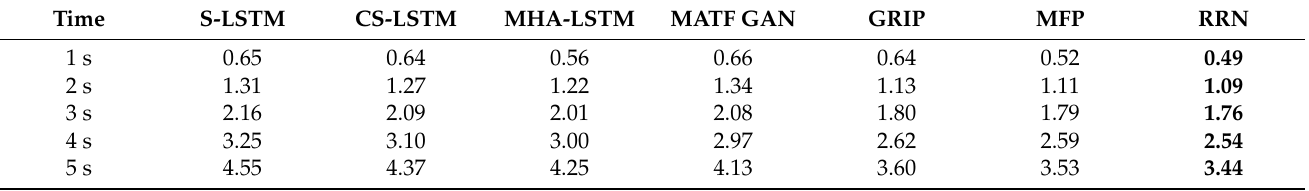
Table 1. RMSE (in meters) results of experiments on the NGSIM. We compare the performance of several baseline models with the RRN over the 5-s prediction